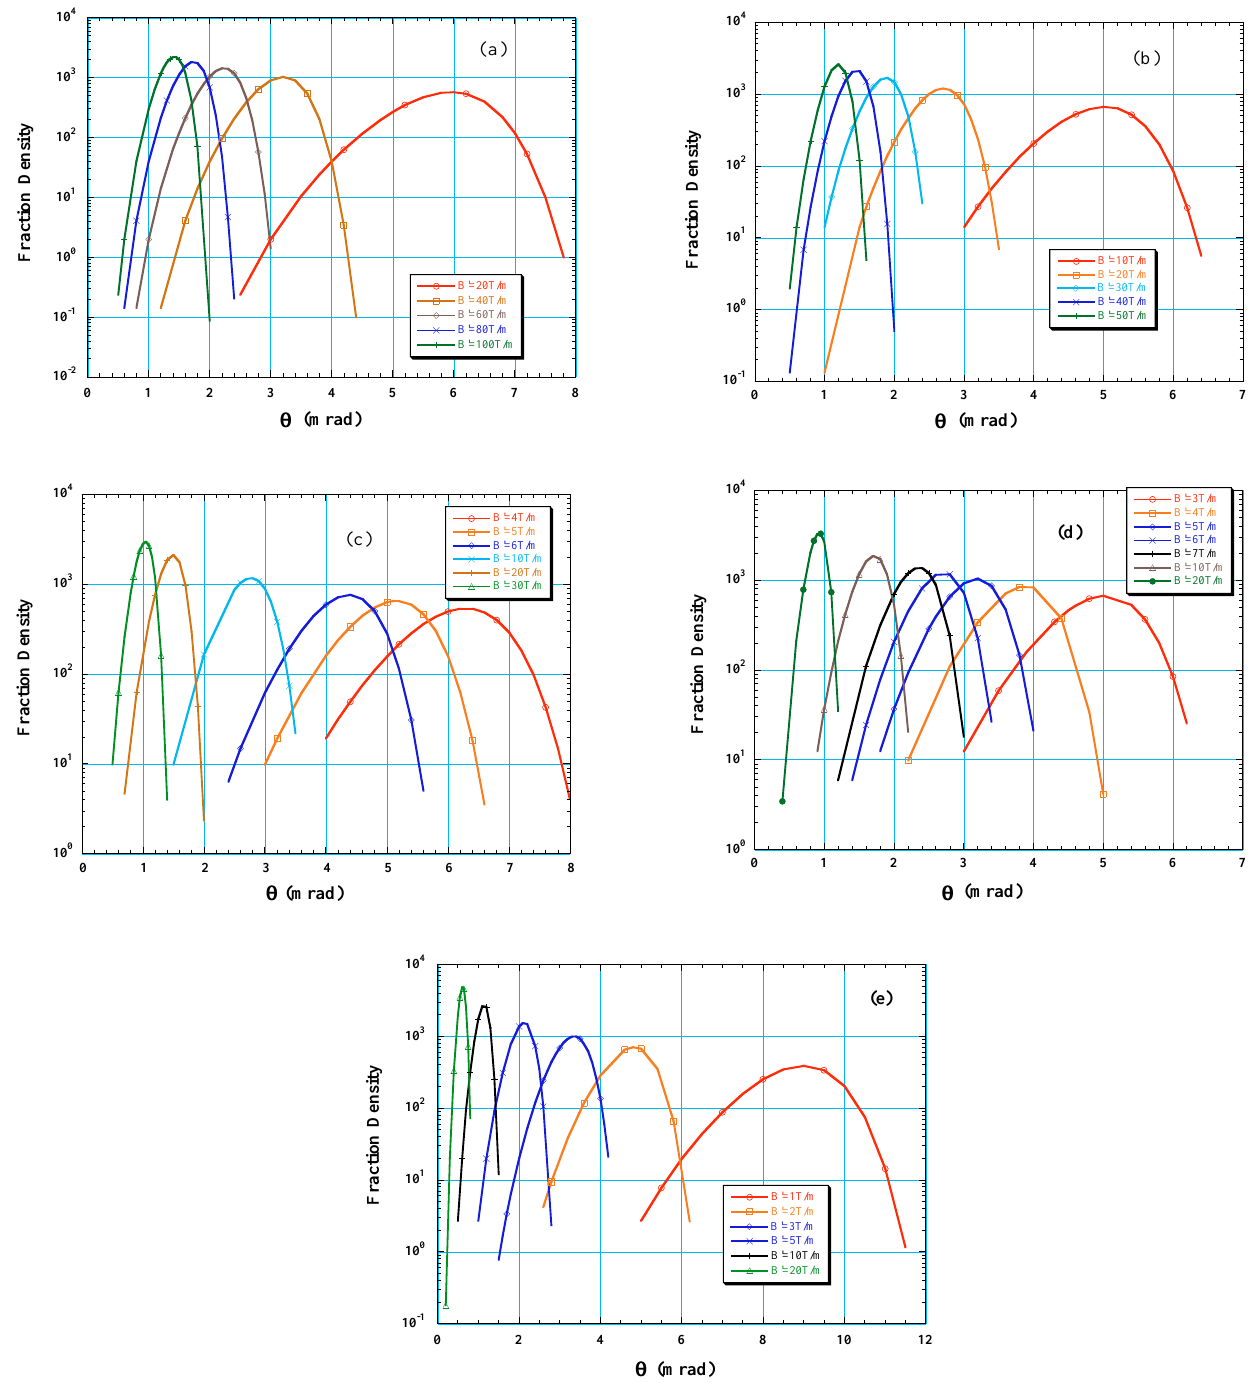
FIG. 6. (Color) Angular distribution of proton beam formed from H (cid:48) (cid:115) (cid:51) (cid:80) (cid:100) pencil beam by Lorentz stripping in a magnetic-field gradient. (a) (cid:84) (cid:173) (cid:49)(cid:46)(cid:48) GeV, (b) (cid:84) (cid:173) (cid:49)(cid:46)(cid:53) GeV, (c) (cid:84) (cid:173) (cid:50)(cid:46)(cid:48) GeV, (d) (cid:84) (cid:173) (cid:50)(cid:46)(cid:53) GeV, and (e) (cid:84) (cid:173) (cid:51)(cid:46)(cid:48)